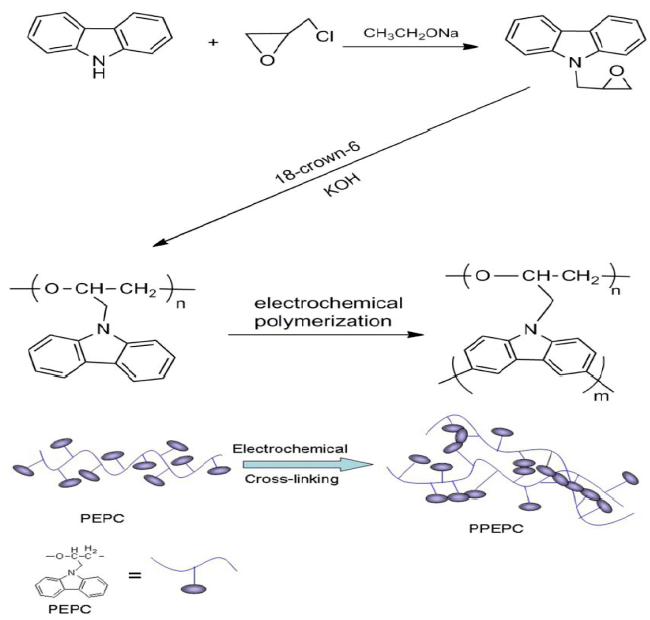
Figure 17. Synthesis route and scheme for PEPC and PPEPC. Reproduced from [147]. (CC by 4.0).